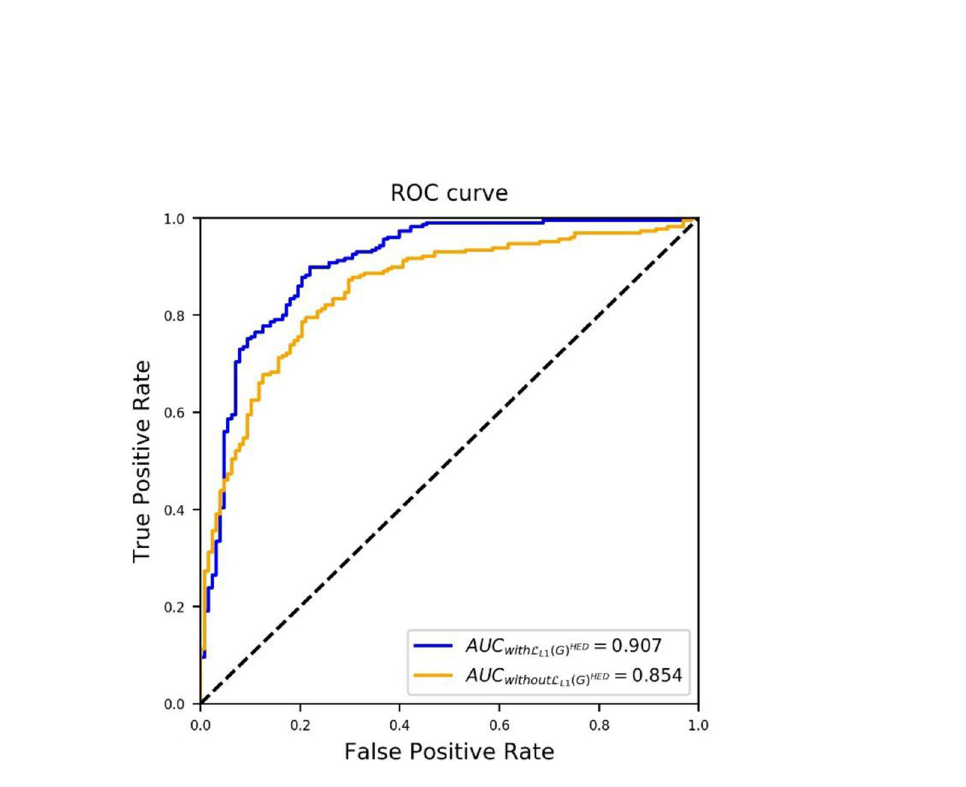
Figure 7. Receiver operating characteristic (ROC) curve of dTSR-scoring performance of the proposed method HED without and with L L 1 ( G )